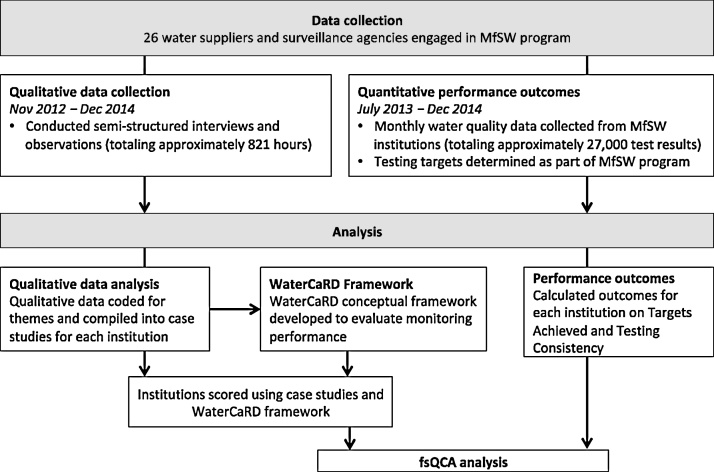
Data collection flow. This figure describes the different steps in data collection and data analysis. The two performance outcomes include (1) Targets Achieved, the overall percent of testing targets met throughout the program duration and (2) Testing Consistency, the percentage of months during which testing targets were met. MfSW = Monitoring for Safe Water; WaterCaRD = Water Capacity Rating Diagnostic; fsQCA = fuzzy-set Qualitative Comparative Analysis.